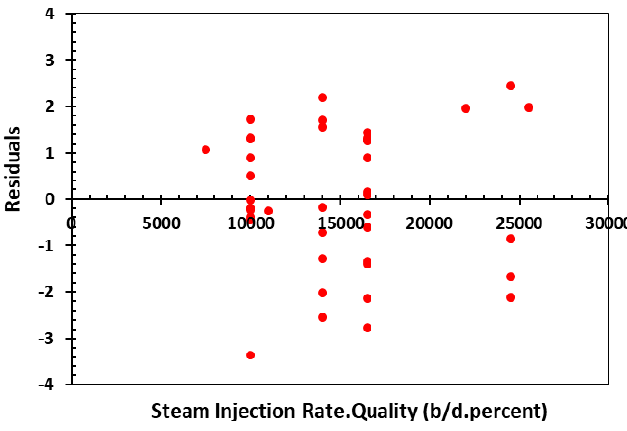
Figure 18. RF vs. oil content for the database analyzed.